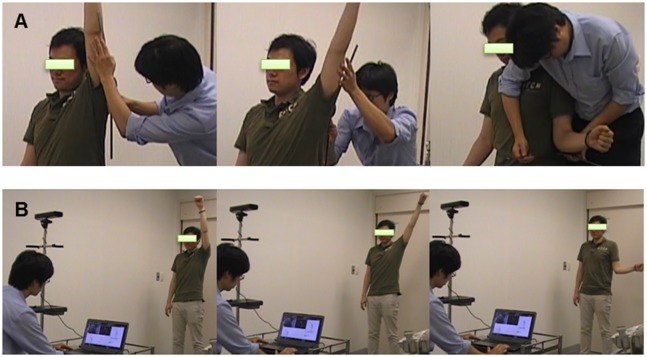
Measurement of the shoulder range of motion (ROM).A. Goniometric active ROM measurement of flexion, abduction, and external rotation by the examiner. B. The Kinect measurement of flexion, abduction, and external rotation ROM under instruction from the examiner. The individual in this figure has given written informed consent (as outlined in PLOS consent form) to publish these case details.